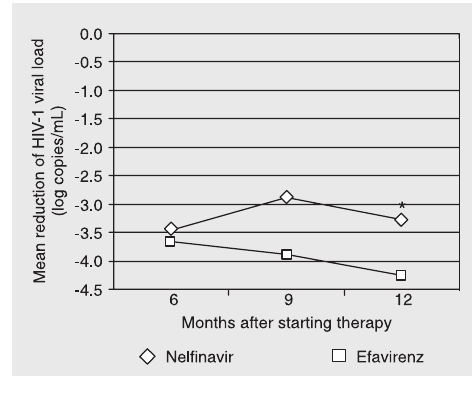
Figure 2. Mean reduction of HIV- 1 viral load (log copies/mL) ac- cording to regimen type. P = 0.02